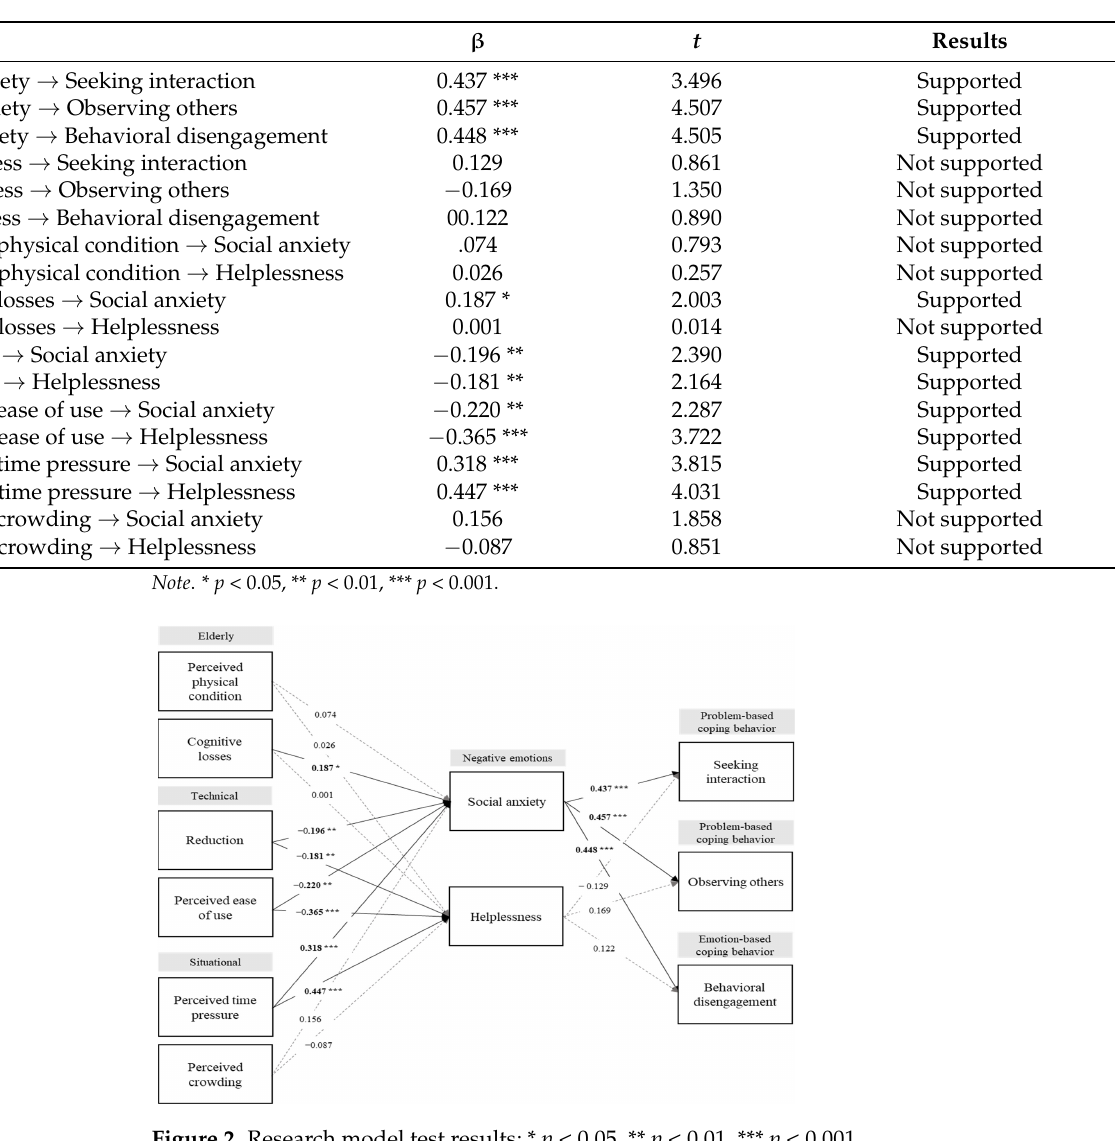
Table 5. Hypothesis testing results.